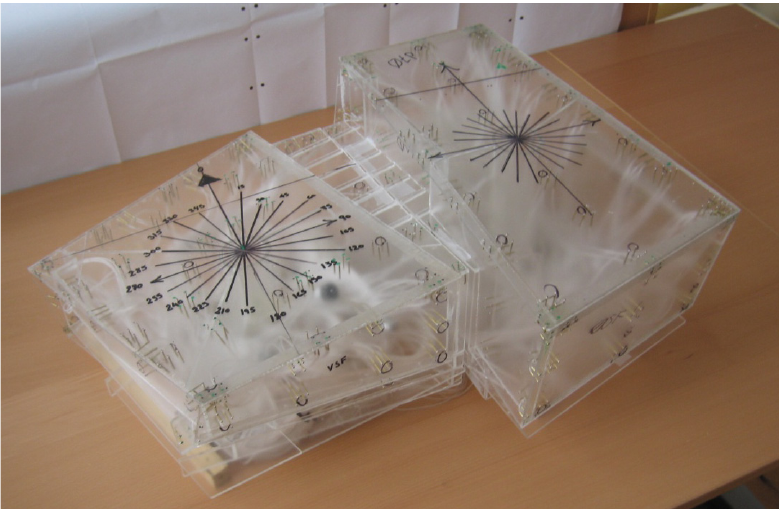
Figure 3. Photo of the 1:200 scale model of the Concert Hall.